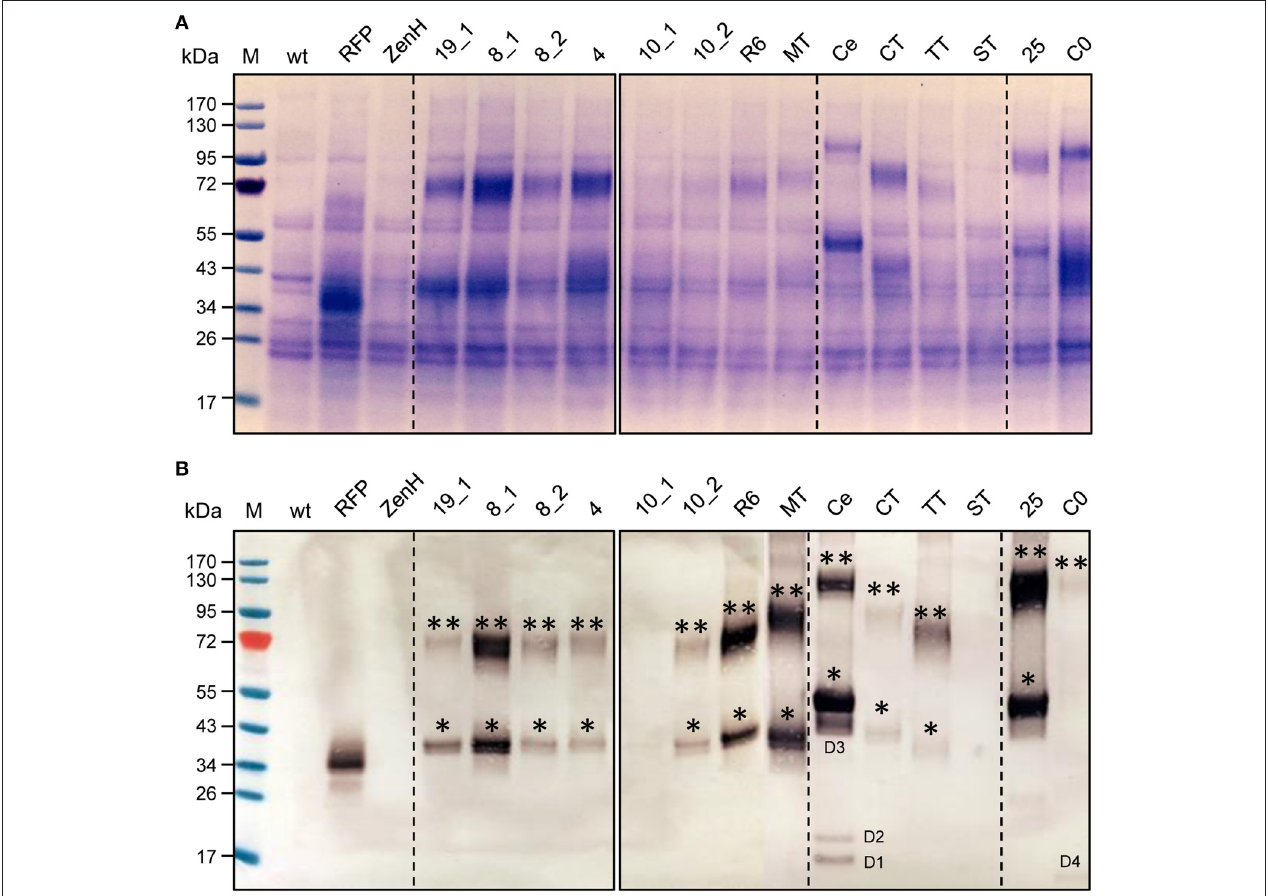
FIGURE 5 | SDS-PAGE and western blot analysis of RFP-fusion proteins. SDS-PAGE (A) and western blot analysis (B) of heat-treated plant extracts obtained from infiltrated N. benthamiana leaves under reducing conditions. Proteins were detected using rabbit anti-His 6 and alkaline phosphatase-labeled goat anti-rabbit antiserum. M, PageRuler TM pre-stained protein ladder (Fermentas); wt, non-infiltrated leaf extract; lane 1, RFP; lane 2, RFP-ZenH, lanes 3–16 contain the samples identified in Table 1 . * Putative monomeric RFP/RFP-fusions; ** putative cross-linked dimeric forms of RFP-fusions. D1-4, putative degradation products.